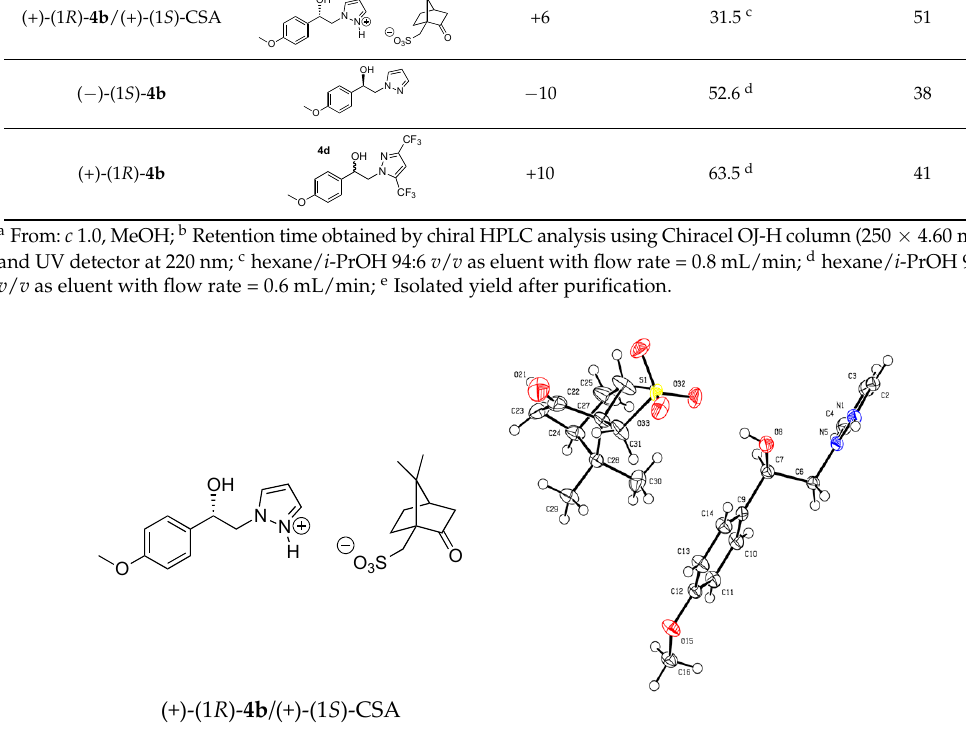
Table 3. Products issued from resolution of ( ± )-(1 R , 1 S ) 1-(4-methoxyphenyl)-2-(1 H -pyrazol-1-yl)ethan-1-ol 4b with ( − )-(1 R )-CSA and (+)-(1 S )-CSA using the method of “half-quantities”. Product [ α D ] a Retention Time t R (min.) b Yield (%) e ( − )-(1 S )- 4b /( − )-(1 R )-CSA